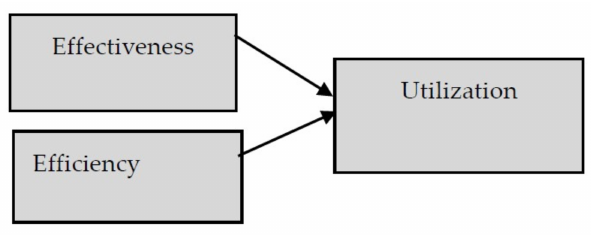
Figure 1. Research model.